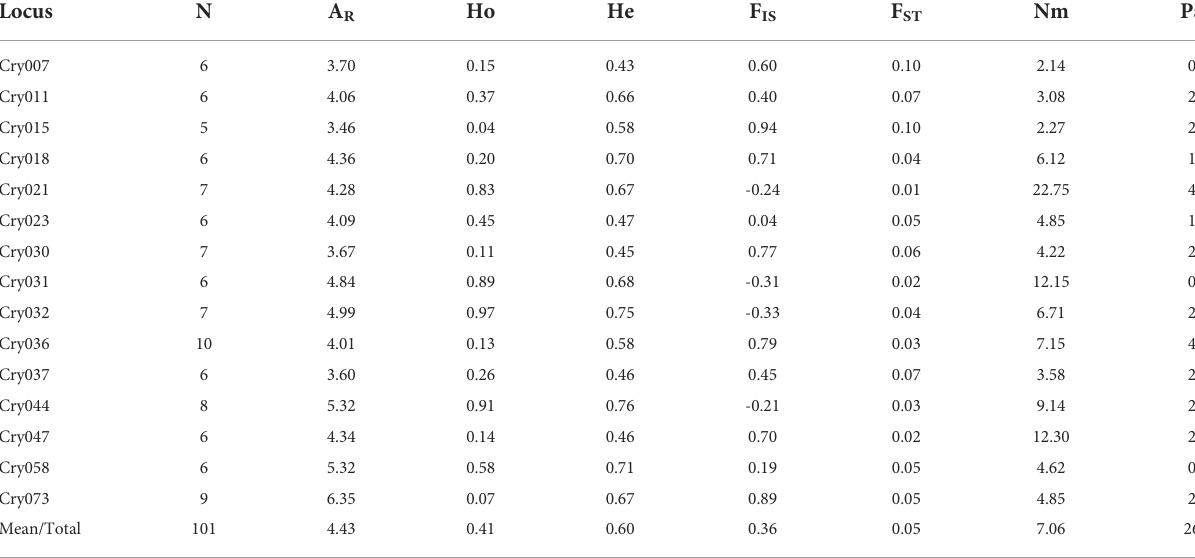
TABLE 2 Diversity indices and gene fl ow estimates for fi fteen microsatellite loci over Cryptolepis sanguinolenta populations. Locus N A R